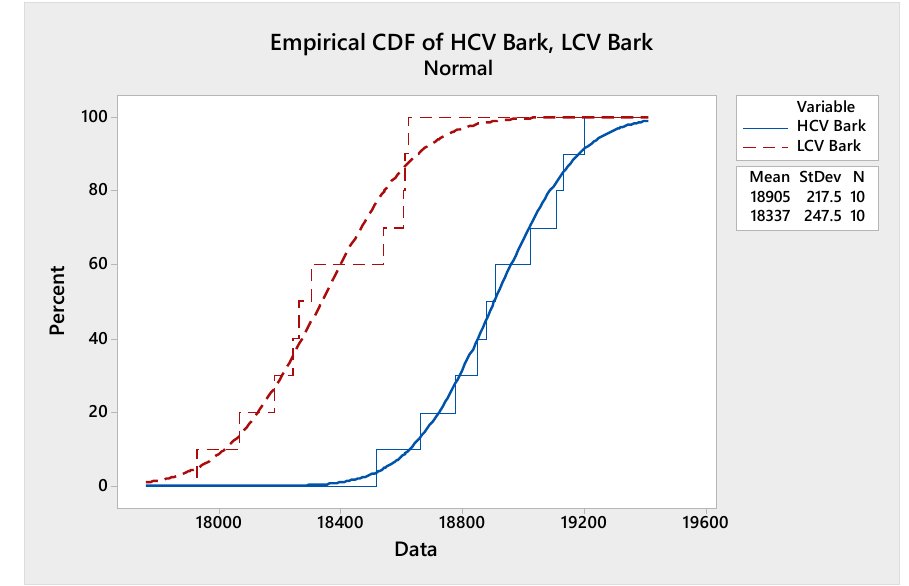
Figure 9. Calorific value of the energy willow bark, Inger’s clone.